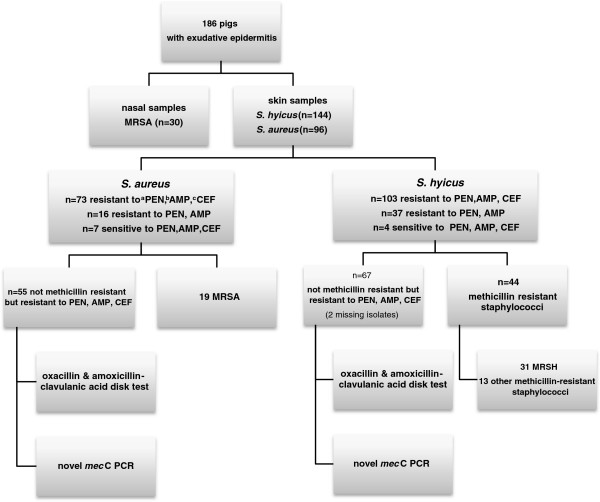
A flowchart of the steps taken to examine the staphylococci isolates from pigs.aPEN: penicillin G bAMP: ampicillin cCEF: ceftiofur.